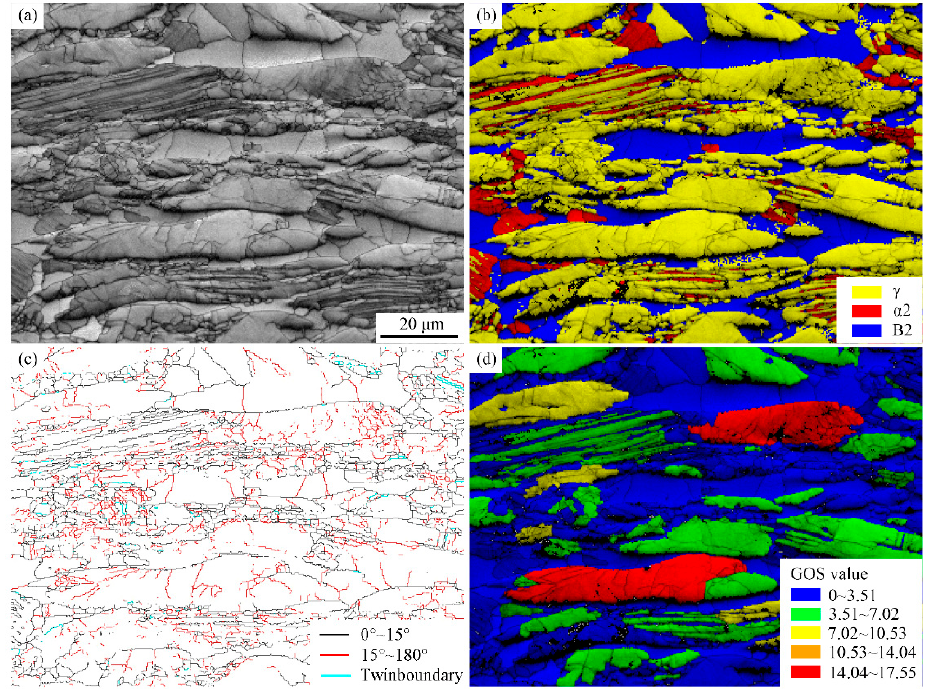
Figure 9. The EBSD analysis of Ti-44Al-5Nb-1Mo-2V-0.2B alloy deformed at 1050 °C/0.1 s − 1 at strain of 50%: ( a ) Image quality (IQ) map; ( b ) phase distribution map; ( c ) grain boundary (GB) map; ( d ) grain orientation spread (GOS) map.